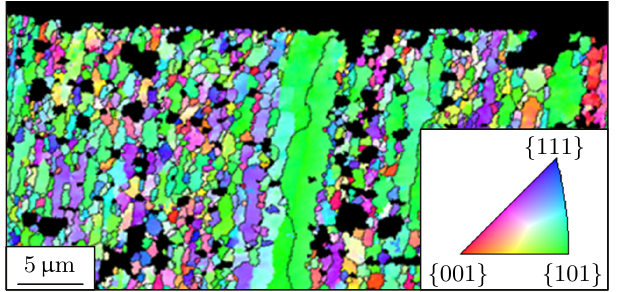
Figure 17. Microstructure of the surface layer for a − 5 ◦ rake angle of the minor cutting edge ( v c =250m/min, f z =0.015mm, a p =0.25mm, a e =0.5mm, α (cid:48) o = 2 ◦